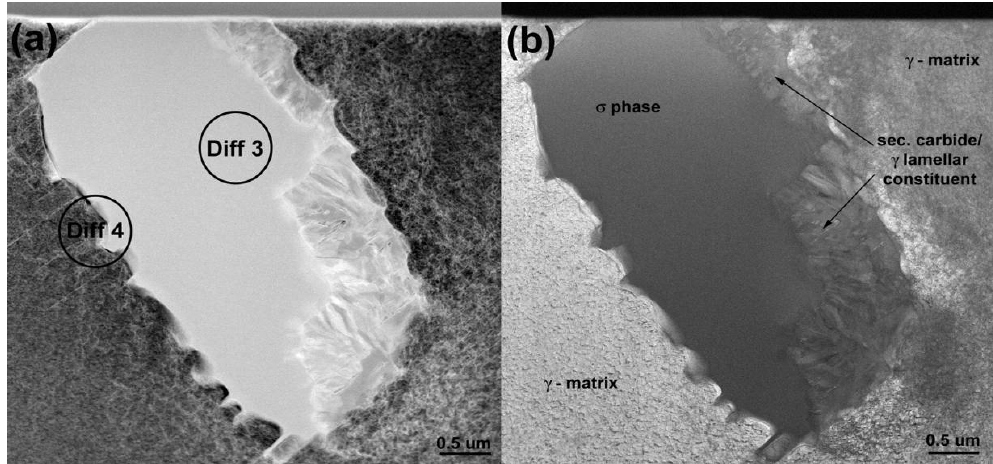
Figure 10. Diffraction pattern of the sigma phase particle shown in Figure 9a.